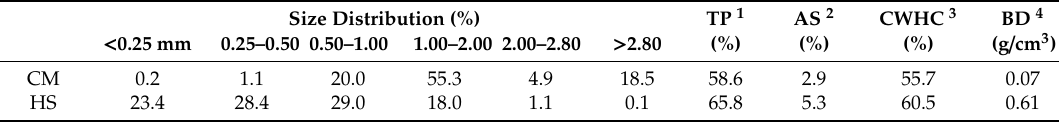
Table 1. Basic physical properties of the commercial media (CM) and humic substances (HS). Size Distribution (%)